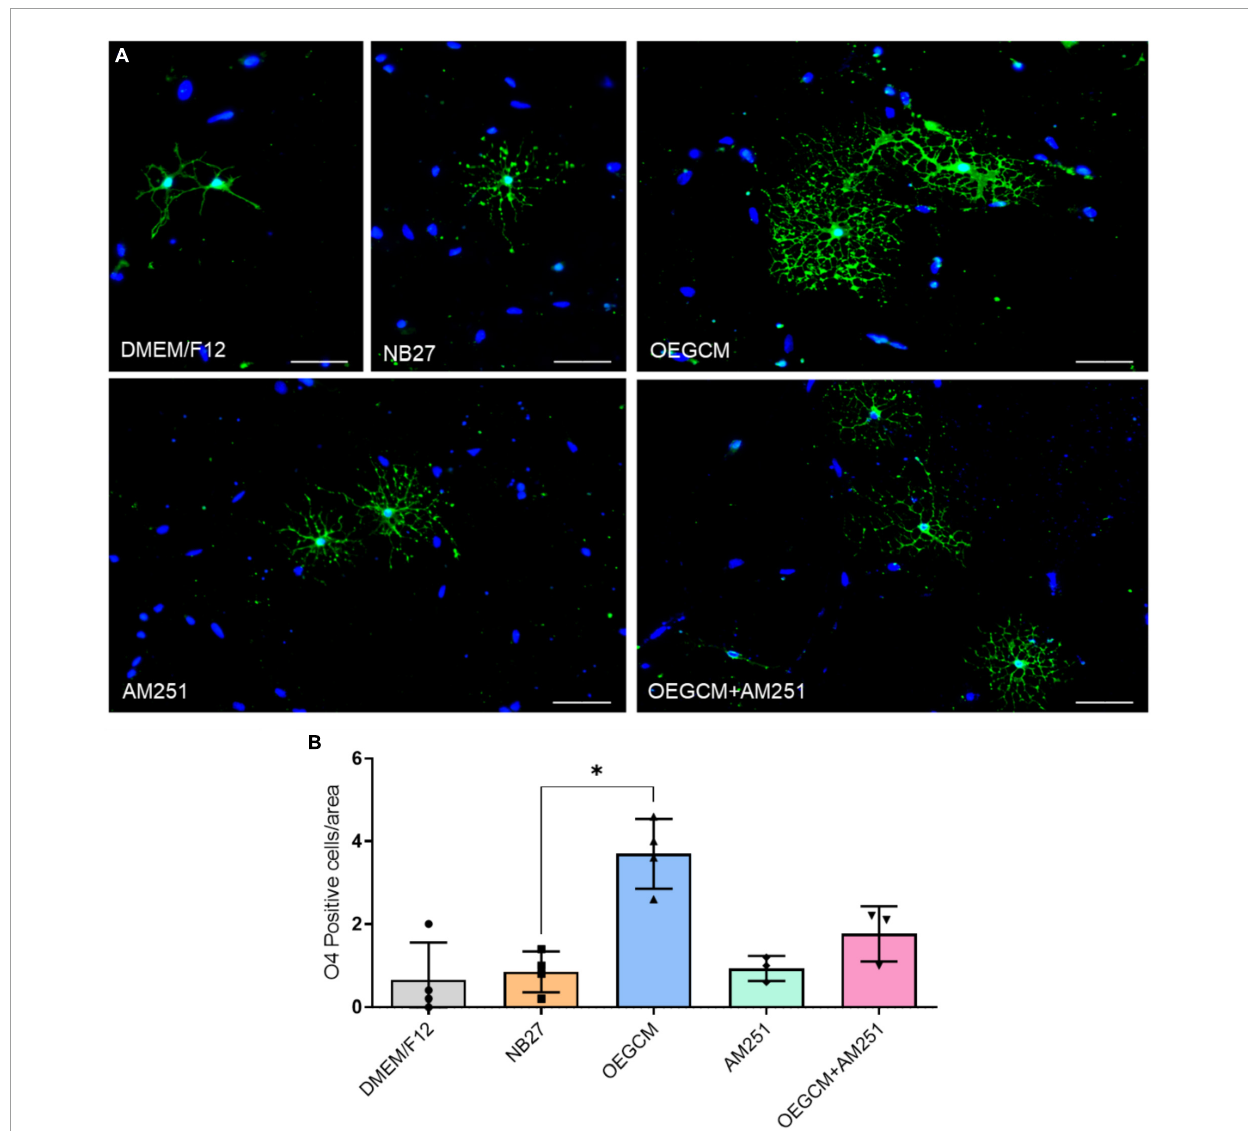
FIGURE4 CB1 receptor blockade tends to decrease the O4-positive cells in hippocampal cells in culture. In panel (A) , representative immunocytochemistry of O4 oligodendrocytes in green and cell nuclei in blue (DAPI). Magnification of 20x, scale bar: 50 µ m. In panel (B) , the number of oligodendrocytes in hippocampal cell culture was evaluated counting the number of O4-positive cells in each condition (for each experiment, 5 images from different areas for each condition was used for the quantification). Data is presented as mean ± SD, statistical analysis was performed using Kruskal-Wallis and Dunn’s as post hoc test. DMEM/F12: N = 4; NB27: N = 4; OEGCM: N = 4; AM251: N = 3; OEGCM + AM251: N = 3; p = 0.0254 for NB27 vs. OEGCM, p > 0.9999 for NB27 vs. AM251, p = 0.7858 for OEGCM vs. OEGCM + AM251, p > 0.9999 for AM251 vs. OEGCM + AM251, p = 0.0690 for OEGCM vs. AM251. * p <